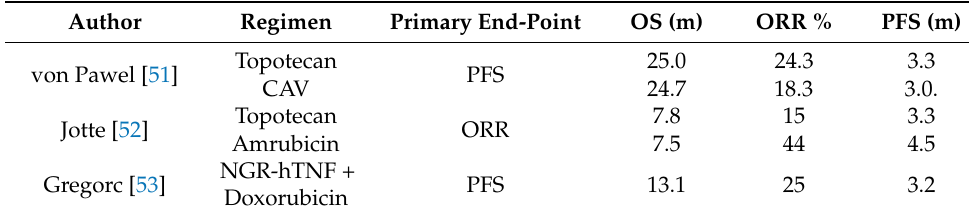
Table 3. Clinical trials exploring second-line therapies in patients with